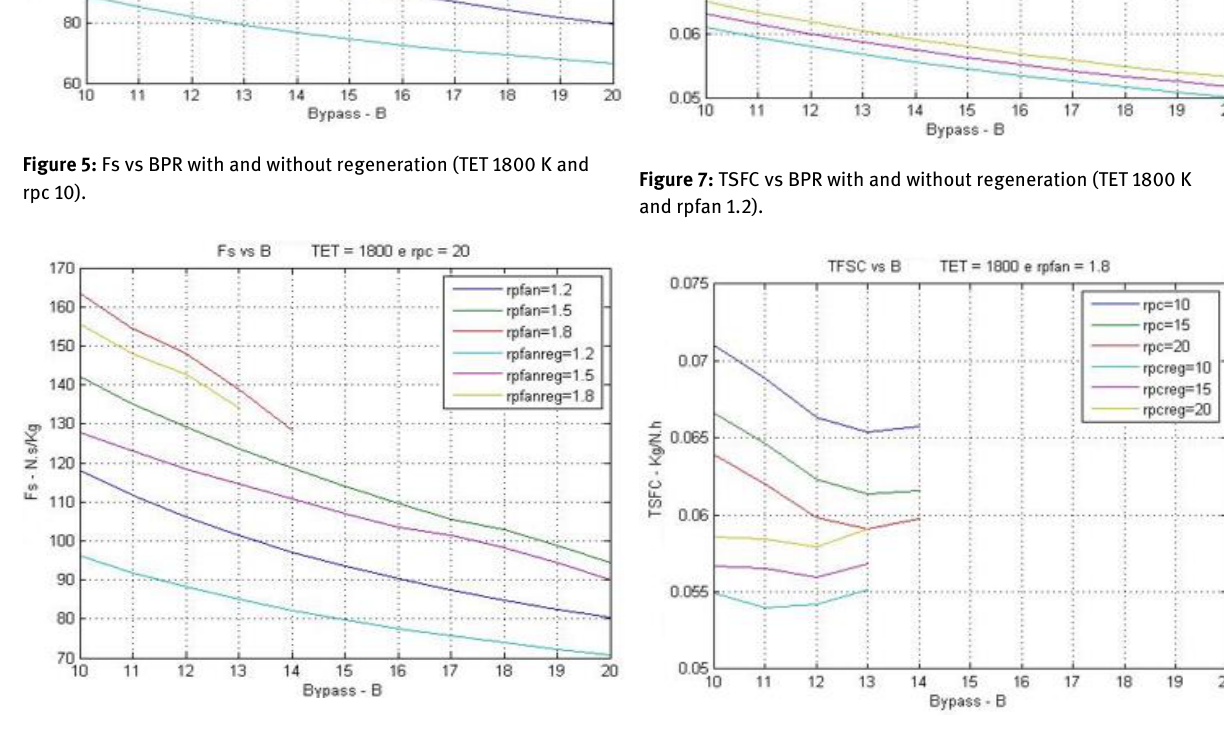
Figure 6: Fs vs BPR with and without regeneration (TET 1800 K and rpc 20). Figure5presentsFsresultsforafixedrpcof10,varying